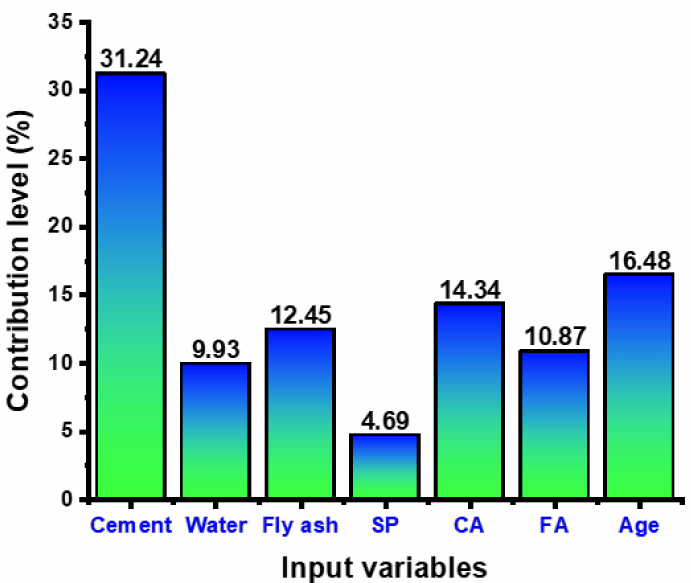
Figure 16. Parameter’s effect on the strength property of FA-based